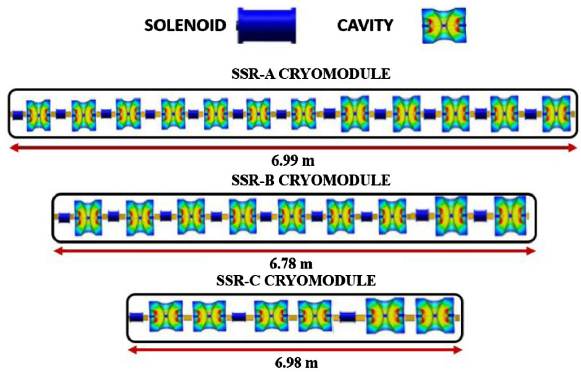
FIG. 33. Cryomodules for the three SSR sections.